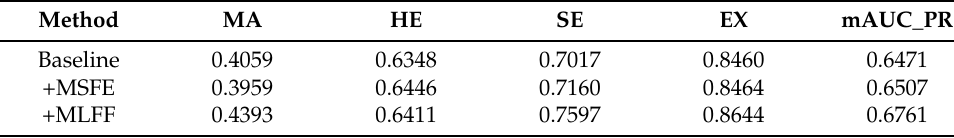
Table 4. Performance comparison of different model